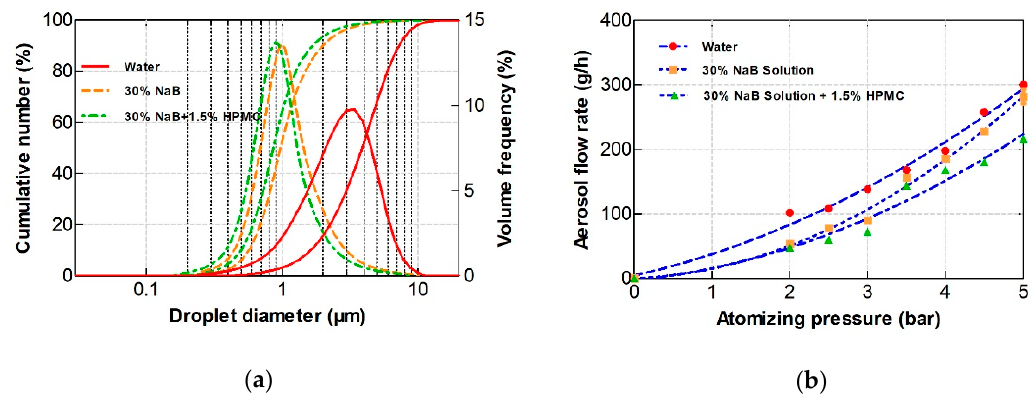
Figure 2. ( a ) Volumetric droplet size distributions in different aerosols generated at 5 bar atomizing air pressure; ( b ) aerosol flow rate vs. atomizing pressure for different liquid solutions.